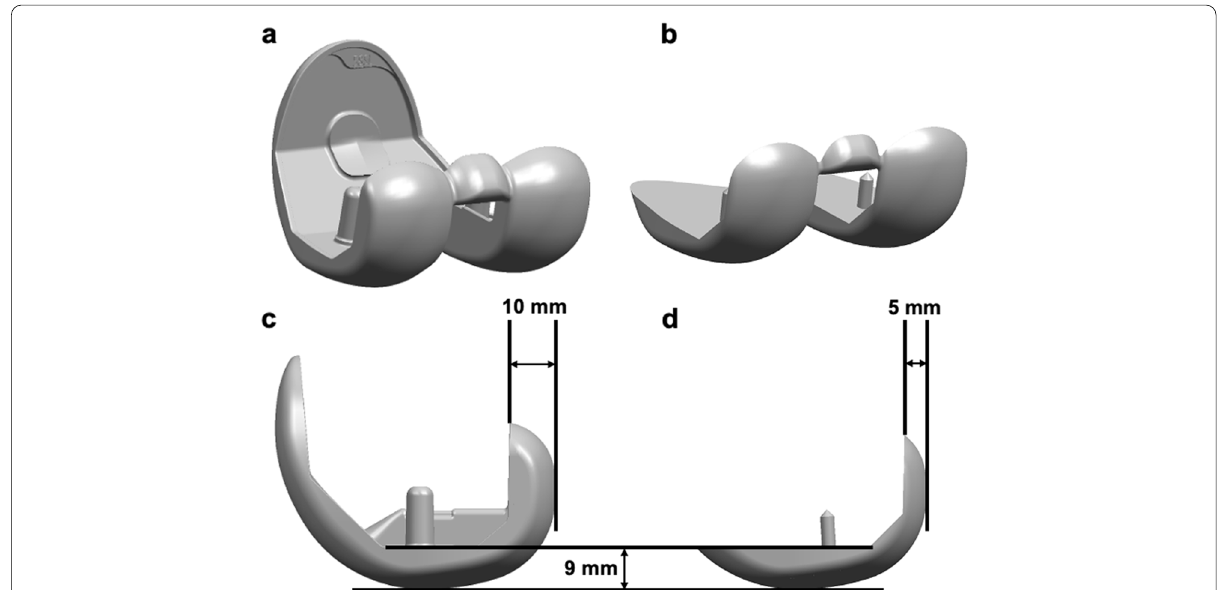
Fig. 1 Femoral component and posterior-stabilised (PS) pre-cut trial (PCT). The femoral component ( a ) and PS PCT ( b ). PS PCT has the same superficial shape as the femoral component. The femoral component has a 9- and 10-mm thickness in the distal and posterior parts, respectively